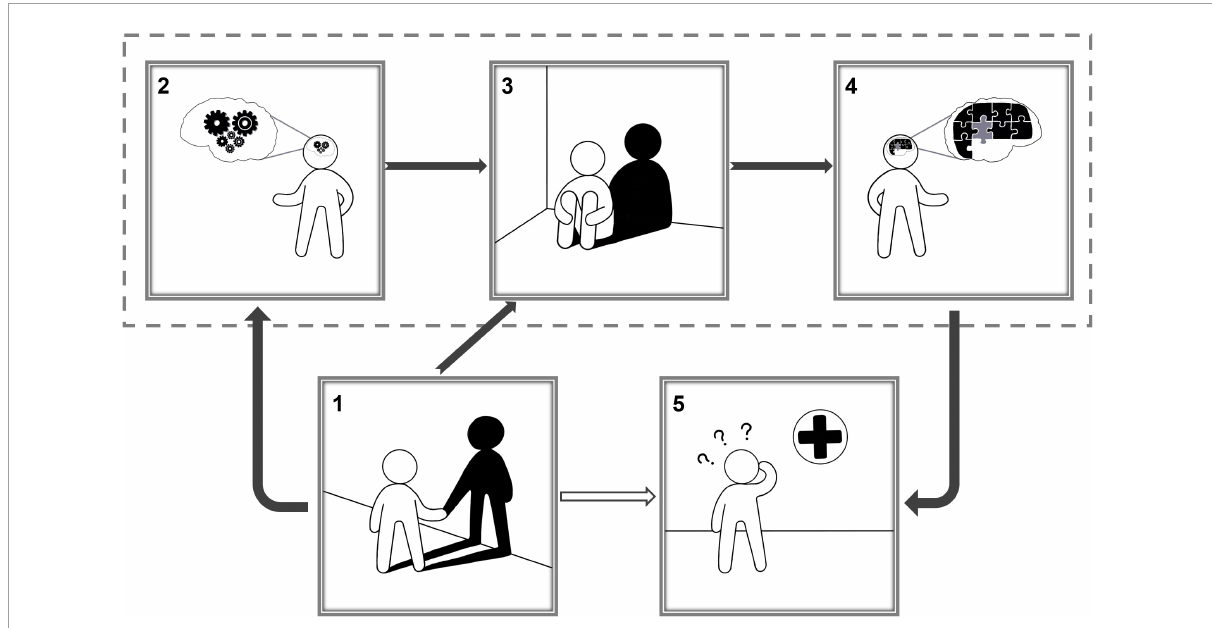
FIGURE5 Schematic diagram of the conclusions of this paper, corresponding to the chain mediation model (1). A lonely person with only his/her own shadow for company; (2) the number of close friends affected a person’s brain activity in specific regions; (3) a depressed person; According to the chain mediation model, the number of close friends affects depression by influencing brain activity, and the number of close friends also directly affects depression; (4). Depression affects a person’s brain activity in specific regions; (5) a person suffering from subjective cognitive decline goes to the hospital; According to the chain mediation model, changes in activity in specific brain regions have an impact on cognitive